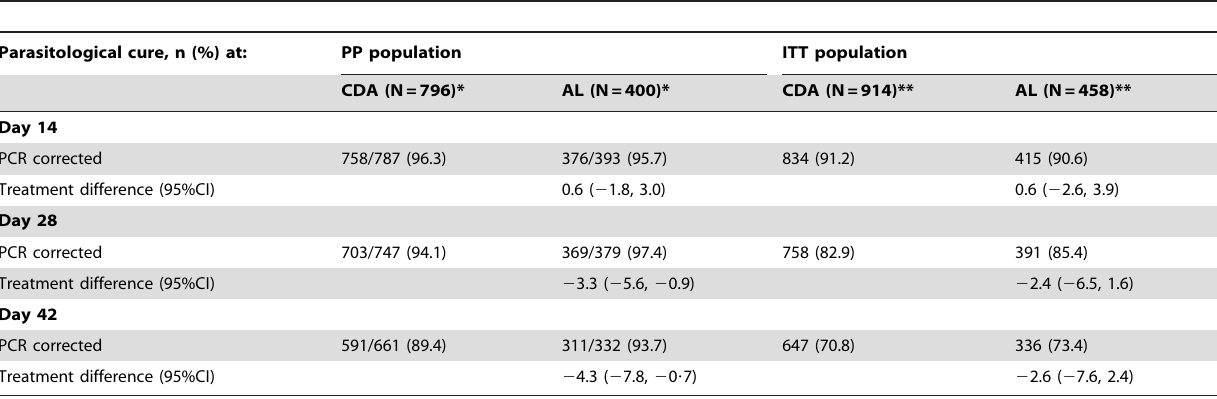
Table 3. PCR-corrected parasitological cure at Day 28 (primary endpoint), Day 14 and Day 42 (secondary endpoints).